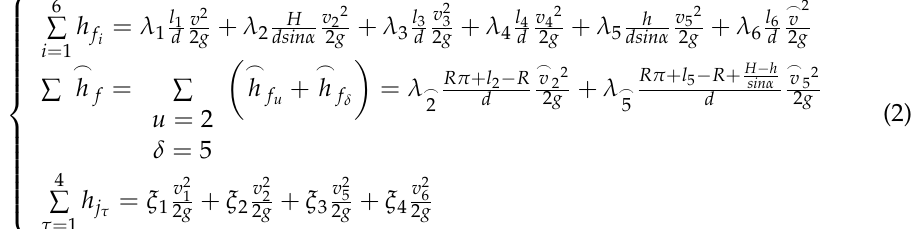
(cid:95) (cid:95) (cid:95) v represent the inflow speed; v 1 , v 2 , v 2 , v 3 , v 4 , v 5 , v 5 , and v 6 , In Equation (2), v and respectively, represent the average flow velocity of liquid in each part (from l 1 to l 6 ) at the stage of liquid inflow. In particular, both parts l 2 and l 5 include an inclined channel and a straight round channel. On the one hand, v 2 represents the average flow velocity (cid:95) v 2 represents the average flow velocity of the straight of the inclined channel at part l 2 ; (cid:95) v 5 , respectively, represent the average flow velocity of round channel at part l 2 ; v 5 and the inclined channel and the average flow velocity of the straight round channel at part (cid:95) l 5 . On the other hand, h f h f and , respectively, represent the friction loss in the inclined 2 2 channel and the straight round channel at part l 2 ; h f and ˆ h f , respectively, represent the 5 5 friction loss and the straight round channel in the inclined channel at part l 5 ; d represents the inside diameter and is 2.8